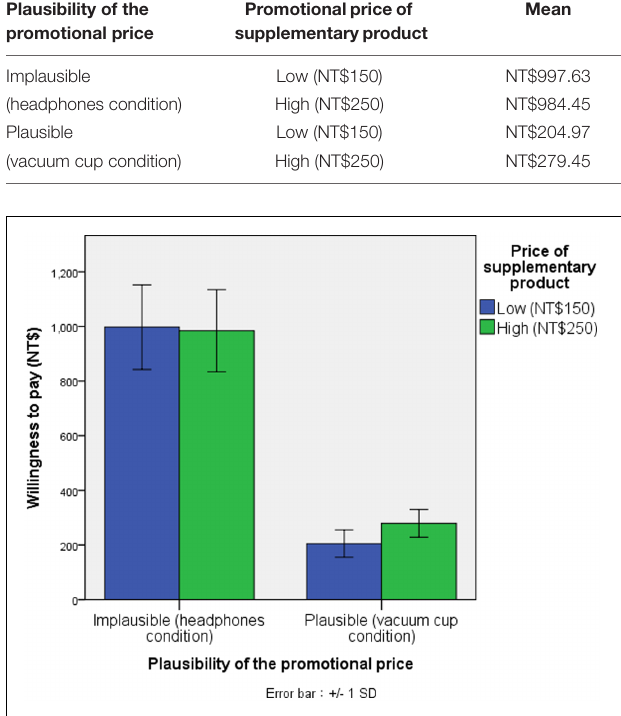
FIGURE 2 | Interaction between the promotional price and its plausibility of the supplementary